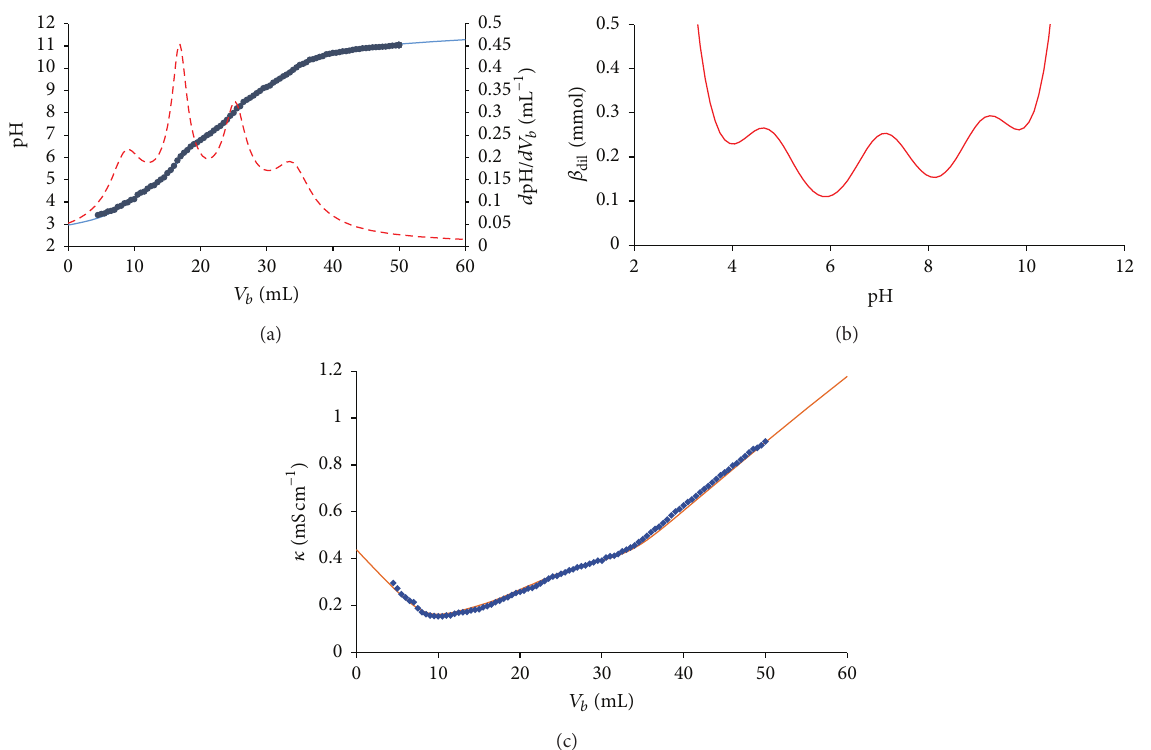
Figure 6: Titration plots of a Britton-Robinson solution, obtained after mixing 30.00 mL of a CH 3 COOH 0.015 molL −1 aqueous solution with 30.00 mL of a H 3 BO 3 0.015 mol L −1 aqueous solution, 30.00 mL aqueous solution of H 3 PO 4 0.015 mol L −1 , and 260 mL water, titrated with NaOH at 0.050 molL −1 concentration. (a) pH-metric plots: the markers represent the experimental recordings obtained (corrected through the efficiency of the cell as indicated in Section 2). The solid line represents the plot pH = 𝑓(𝑉 𝑏 ) estimated (22) whereas the segmented line represents the 𝑑 pH /𝑑𝑉 𝑏 = 𝑓 󸀠 (𝑉 𝑏 ) ≈ Δ pH /Δ𝑉 𝑏 , obtained from the fitted model. (b) Plot of buffer capacity with dilution ( 𝛽 = 𝐶 (𝑑𝑉 /𝑑 pH ) ≈ 𝐶 (Δ𝑉 /Δ pH ) , as a function of pH, for the Britton-Robinson solution. (c) Conductometric plot 𝜅 = 𝑔(𝑉 as 𝛽 𝑏 𝑏 𝑏 𝑏 dil markers represent the experimental points obtained and the solid line represents the estimated plot with